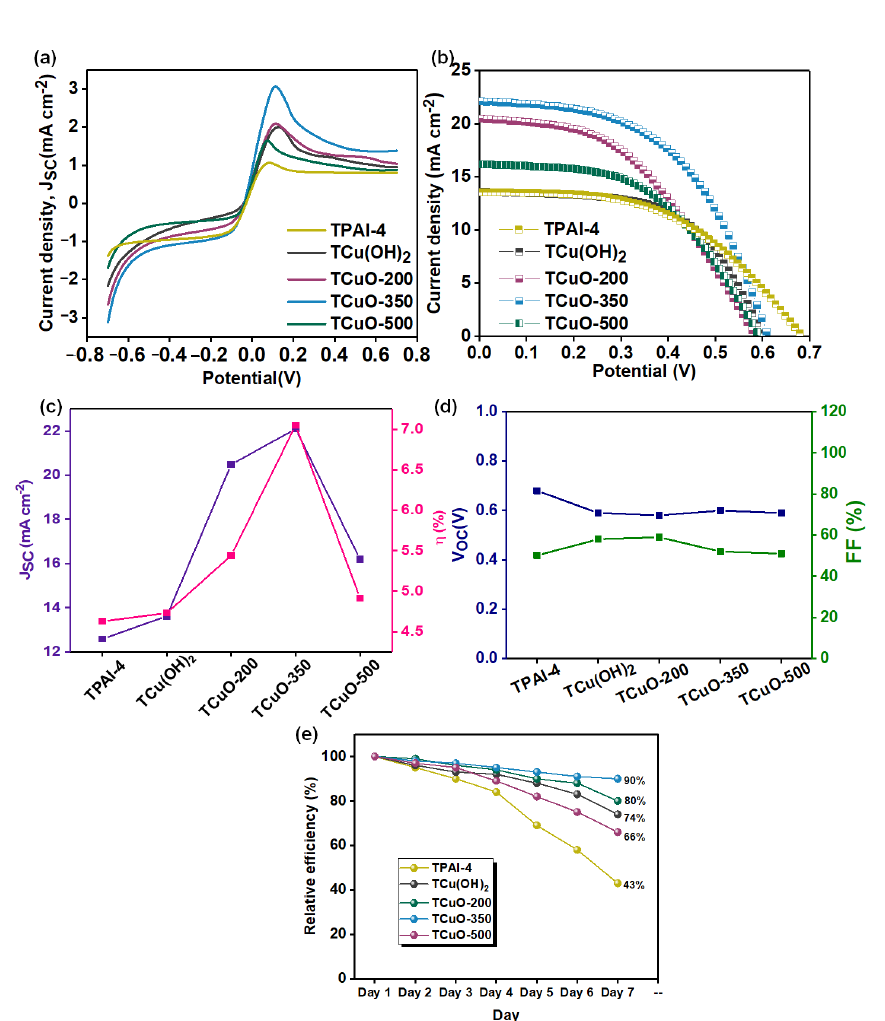
Figure 7. ( a ) LSV curve, ( b ) J-V curve, ( c ) parameter of short-circuit current density ( J SC ) and conver- sion efficiency ( η ) graph, ( d ) parameter of open-circuit voltage ( V OC ) and fill factor ( FF ) graph, and ( e ) stability of DSSC for all PCGE samples.